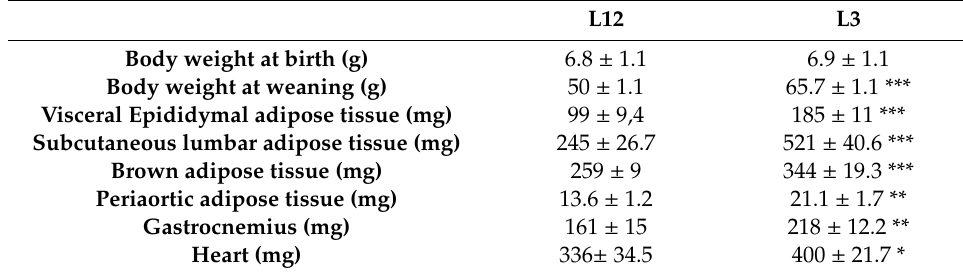
Table 1. Body and organ weights from L12 (lean) and L3 (overfed) rats.